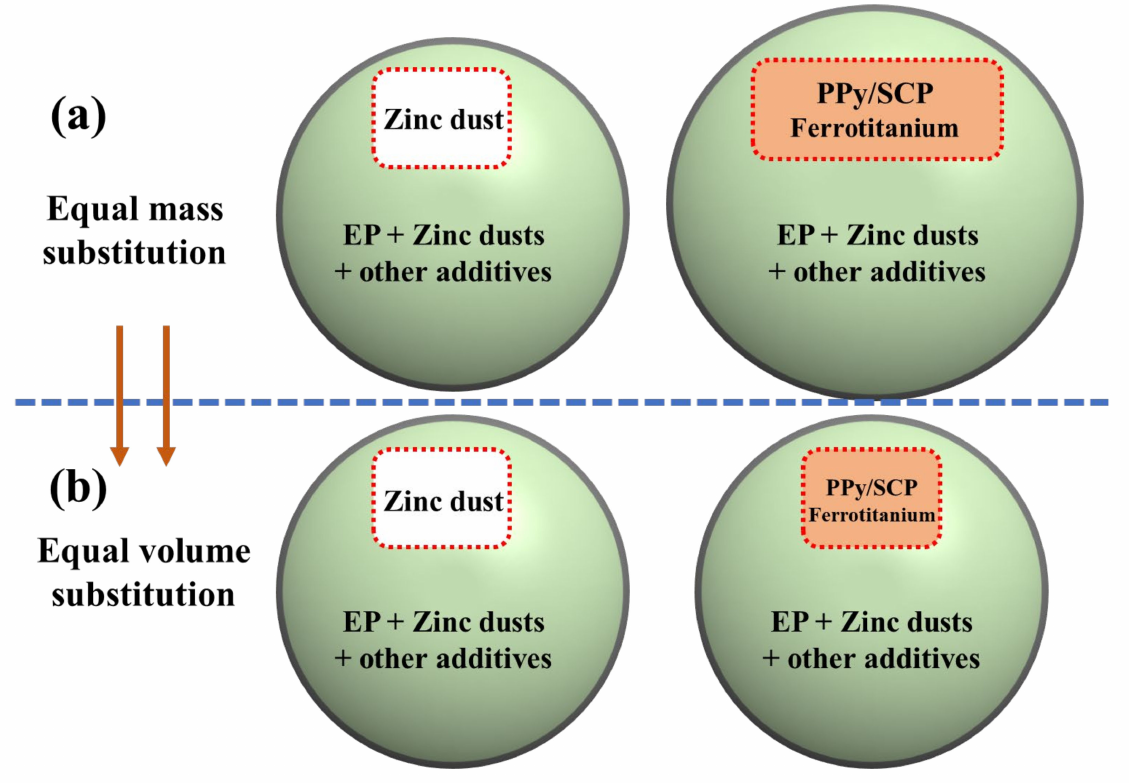
Figure 6. The schemes of equal mass substitution ( a ) and equal volume substitution ( b ) of conductive PPy/SCP particles and ferrotitanium powders to zinc